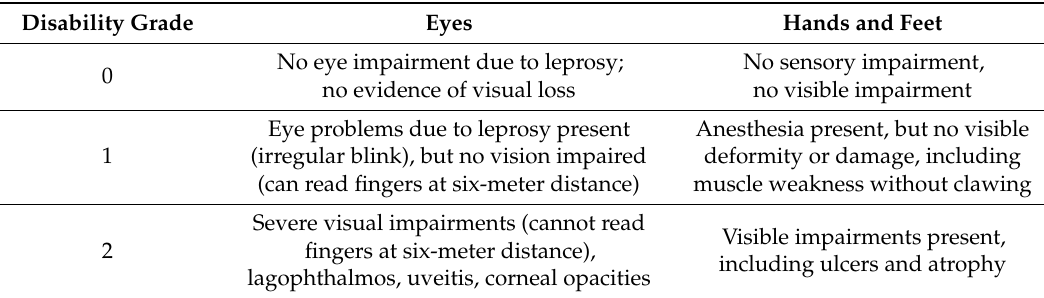
Table 1. Disability grading in